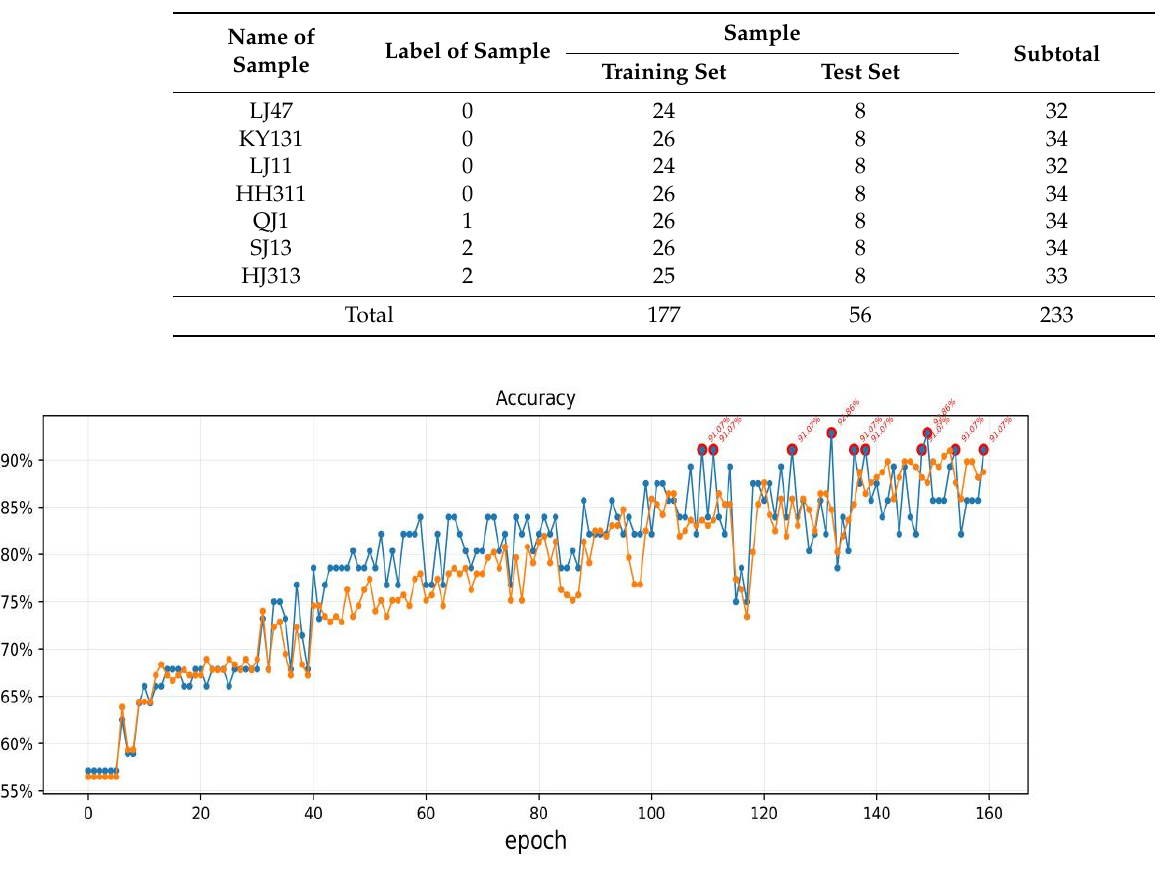
Figure 9. Classification results of japonica rice GD by CapsNets model. Epoch represents the number of training cycles of the model, and the yellow line and blue line represent the accuracy of training datasets and test datasets, respectively.